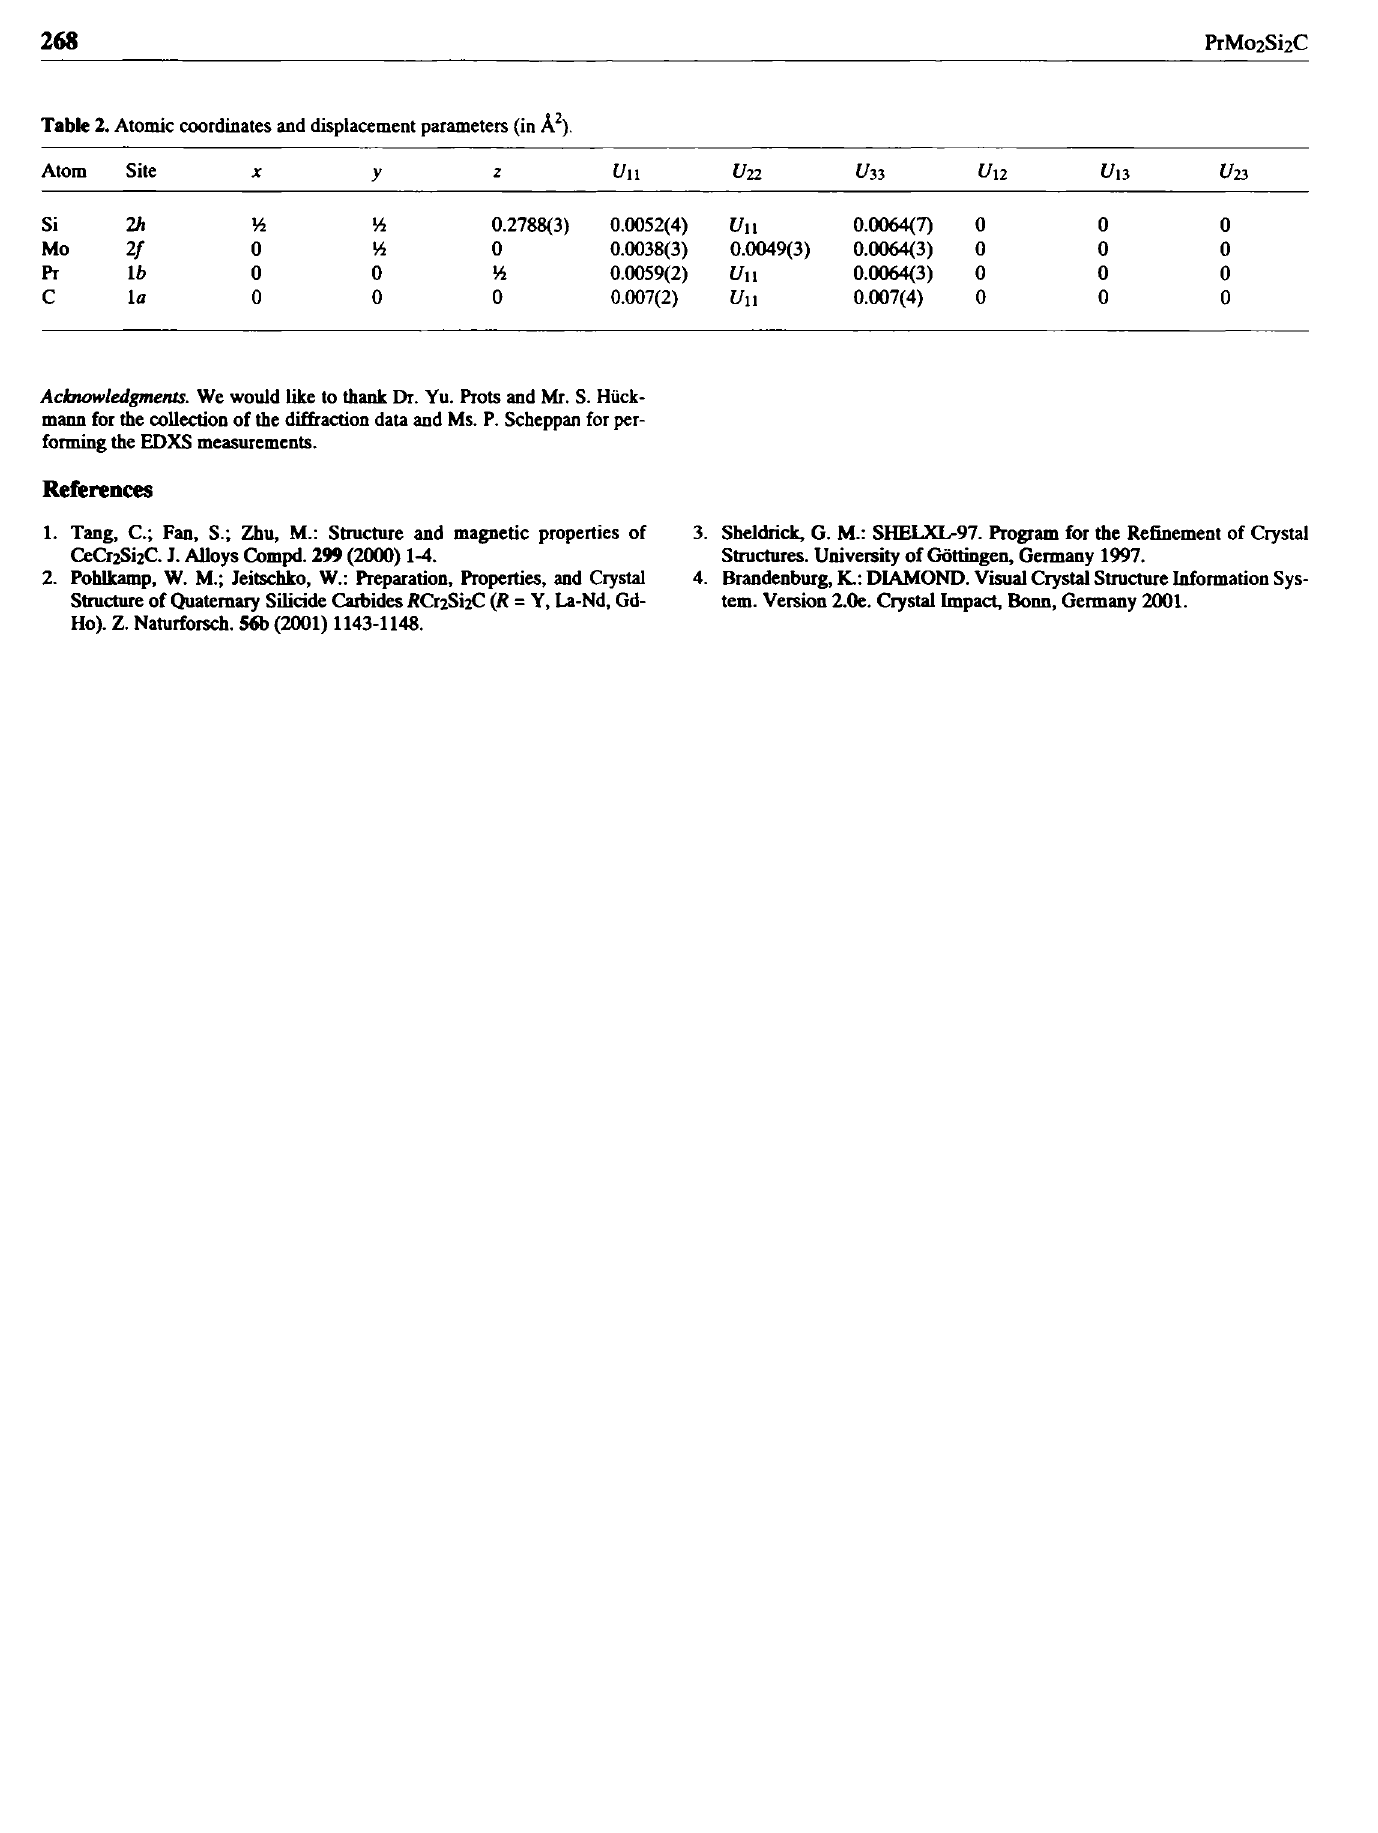
Table 2. Atomic coordinates and displacement parameters (in A 2